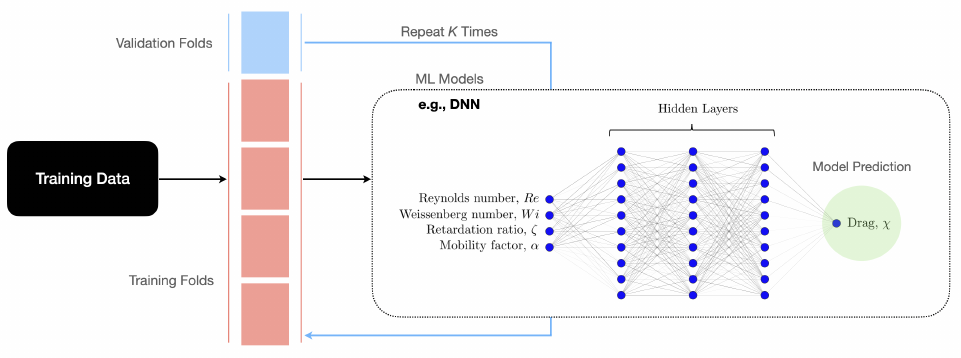
Figure 2. A summary of the training approach, input and output features to develop ML-based regression models (e.g., it is shown for a DNN